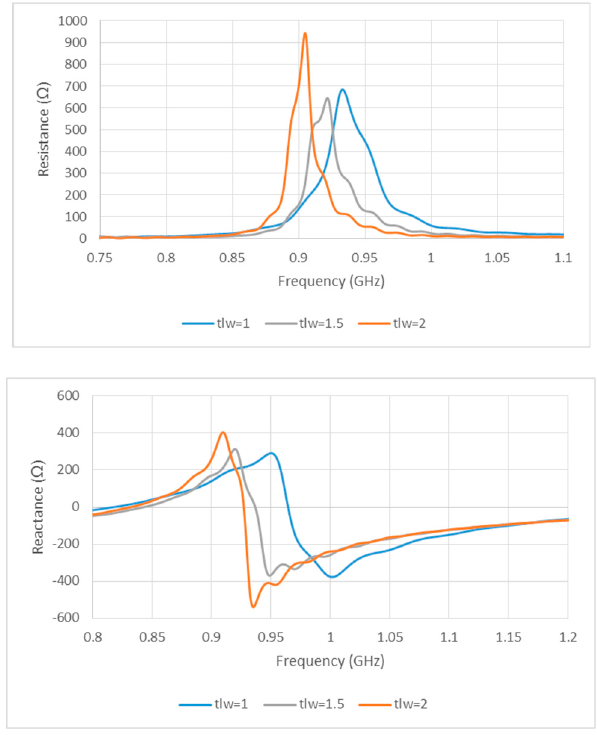
Figure 2. Simulated input impedance for various transmission line widths.